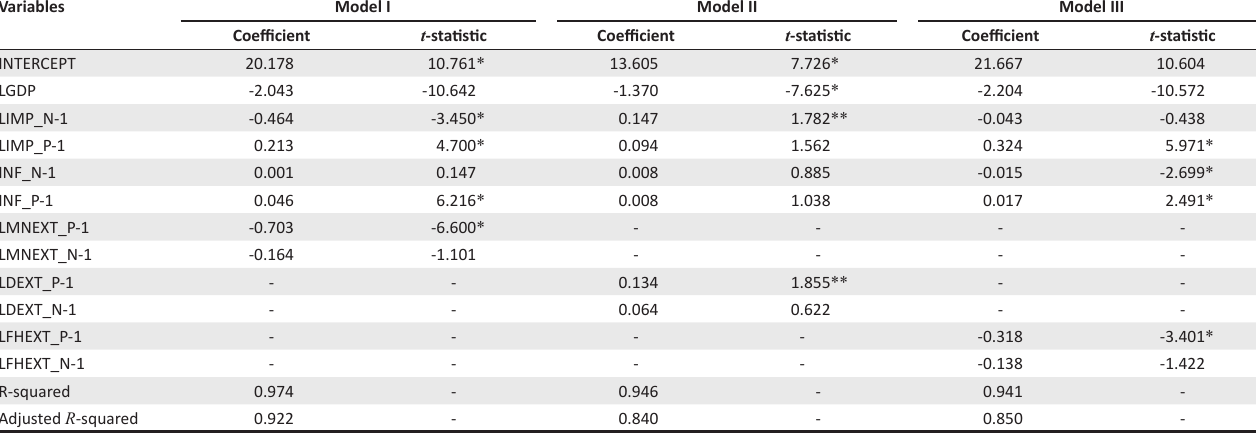
TABLE 7: Non-linear autoregressive distributive lag long-run estimation results. Variables